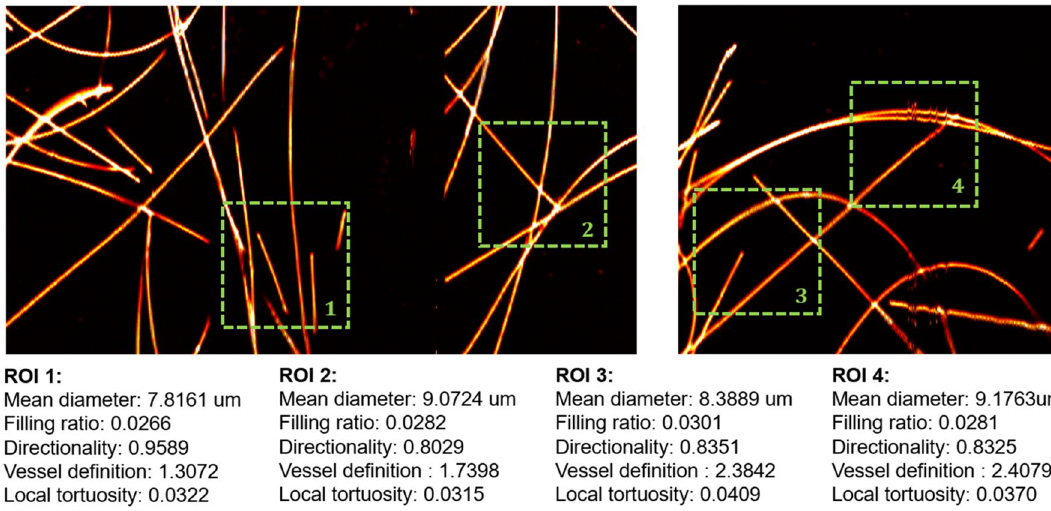
Figure 1. OR-PAM images of carbon fibers. Four ROIs containing carbon fibers with various arranged positions were selected to evaluate the accuracy and consistency of the quantification